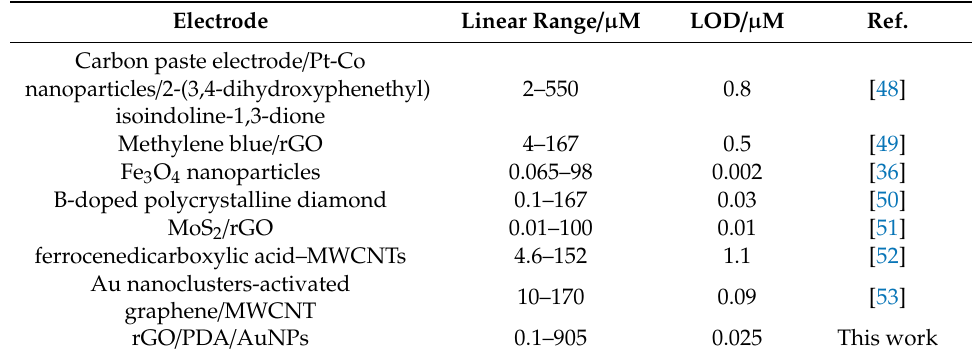
Table 3. Comparison of folic acid analytical parameters between rGO / PDA / AuNPs film and reported modifiers.